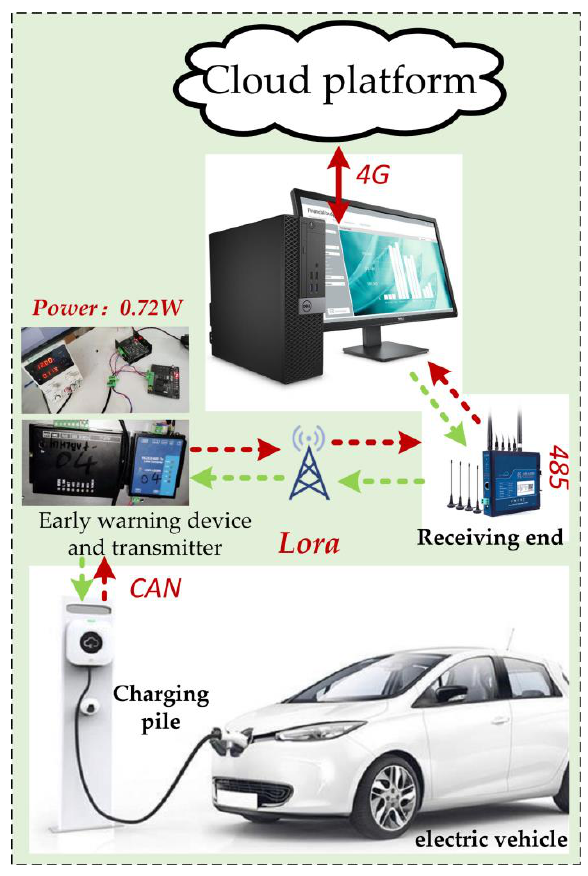
Figure 4. System composition data transmission mechanism.